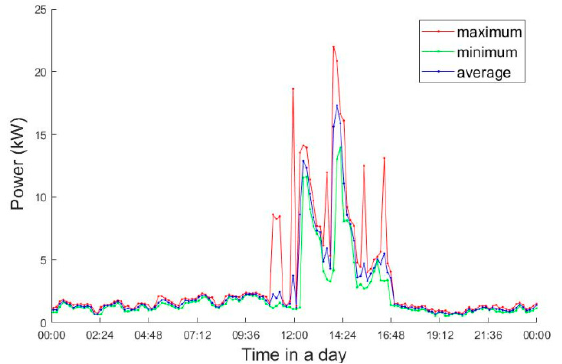
Figure 7. Curve of load data accessed on grid side.